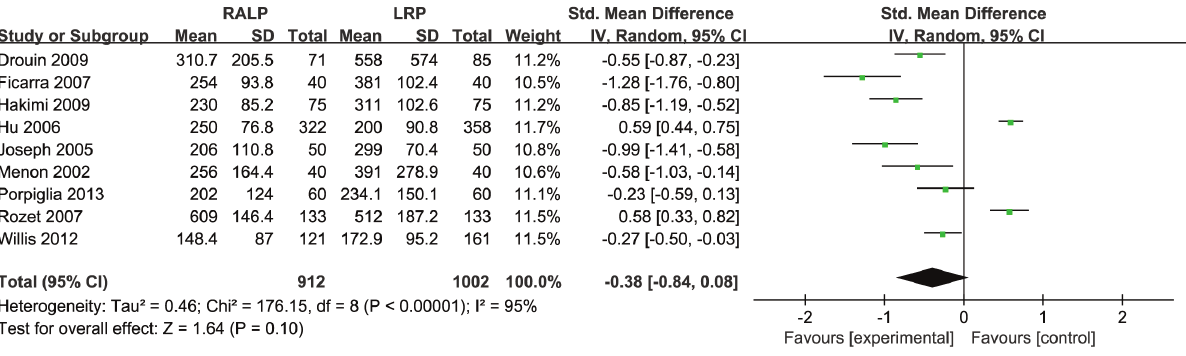
Figure 2: The forest plot for surgical blood loss of RALP and LRP groups